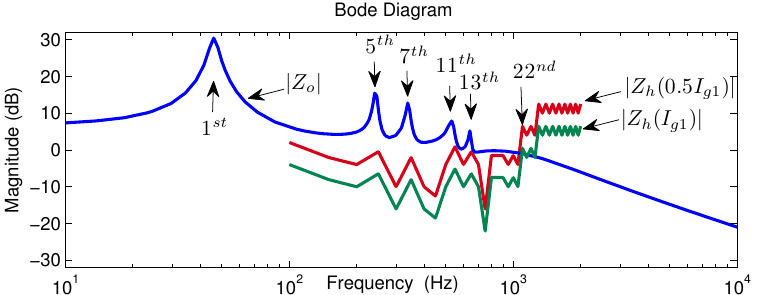
Figure 8. Magnitude of the output impedance with MPR current controllers and the output harmonic impedance limit at rated and half power.